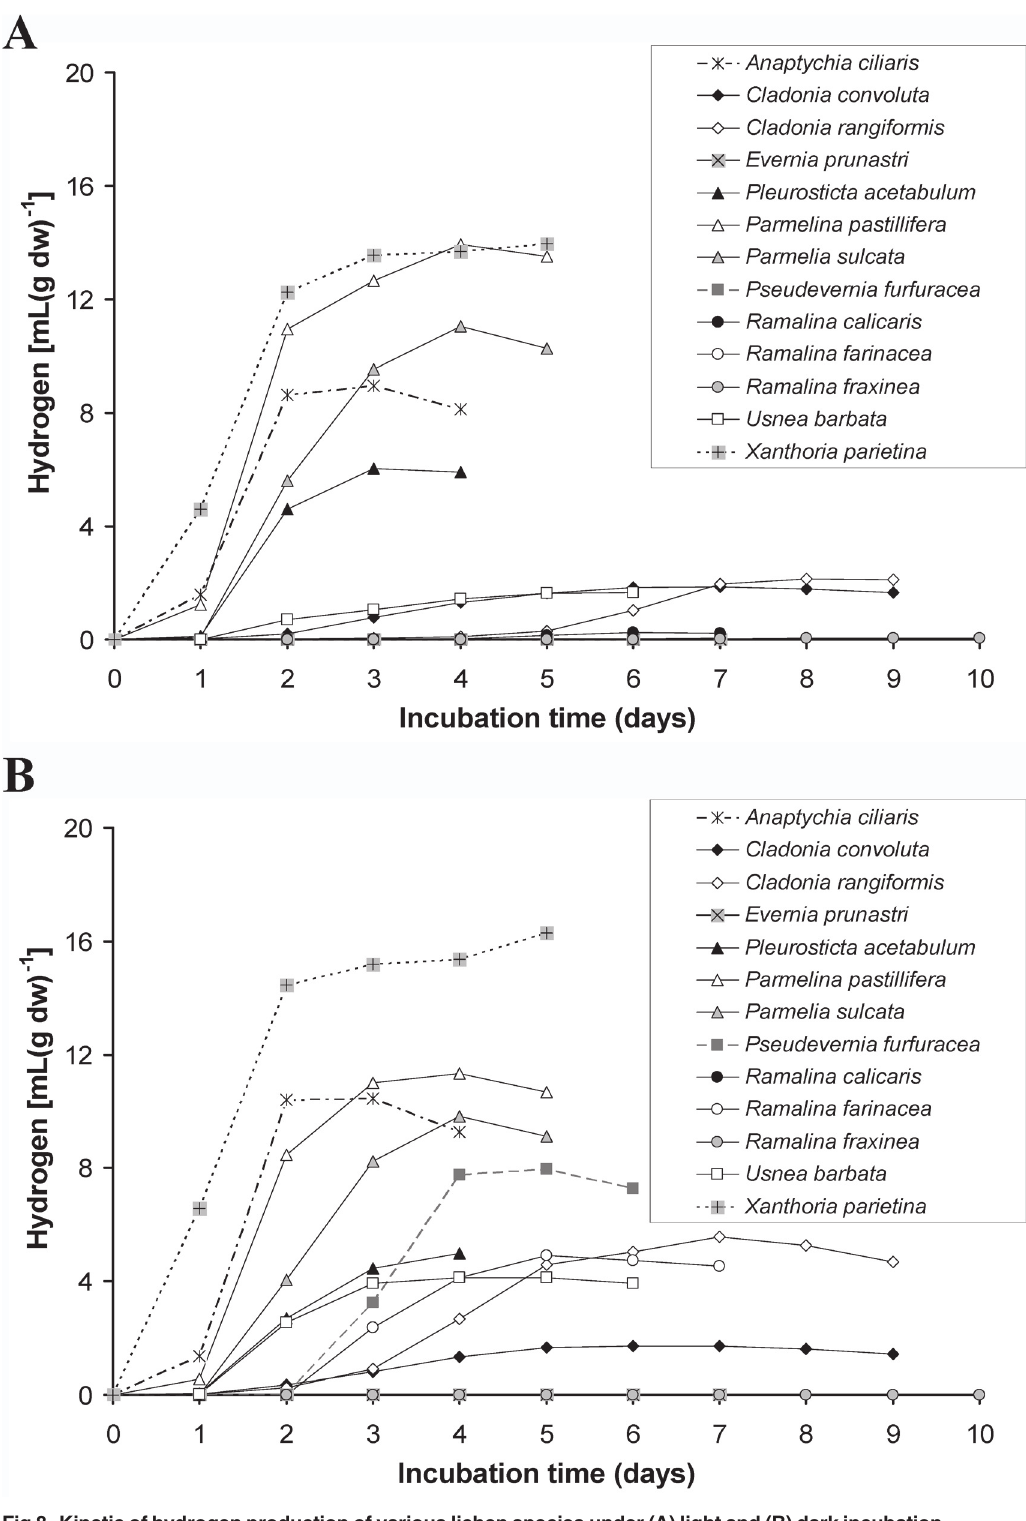
Fig 8. Kinetic of hydrogen production of various lichen species under (A) light and (B) dark incubation.